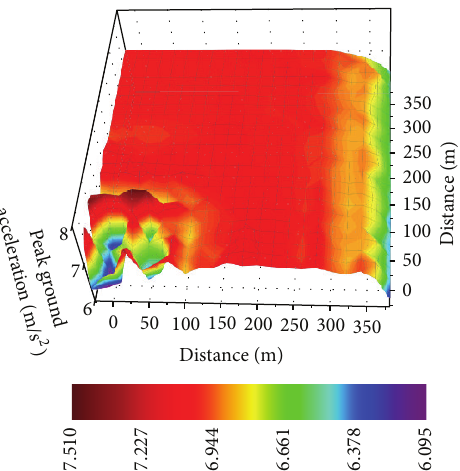
Figure 17: Peak ground acceleration distribution of URBAN4-4 (1/4 FE model, 𝐷 = 1.25 , El Centro, 𝑆𝑋 ).